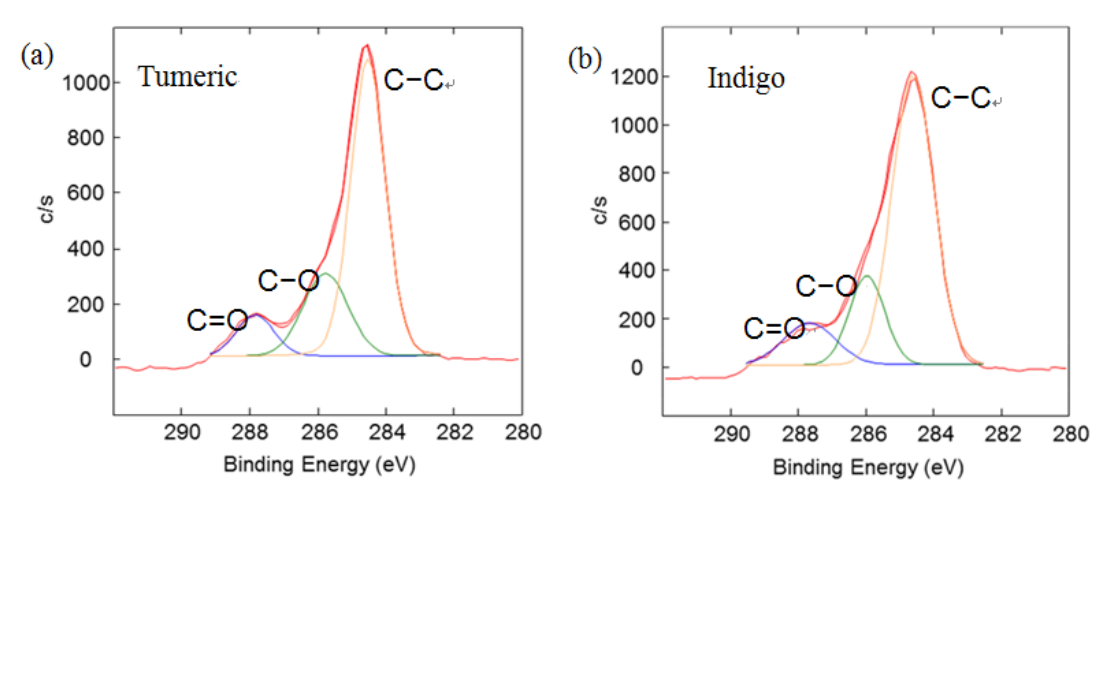
Figure 4. Results of the curve fitting analysis of C1s spectrum measured for silk textiles dyed with plant extracts. ( a ) Turmeric; ( b ) Indigo; ( c ) Sappanwood; ( d ) Gromwell; ( e )